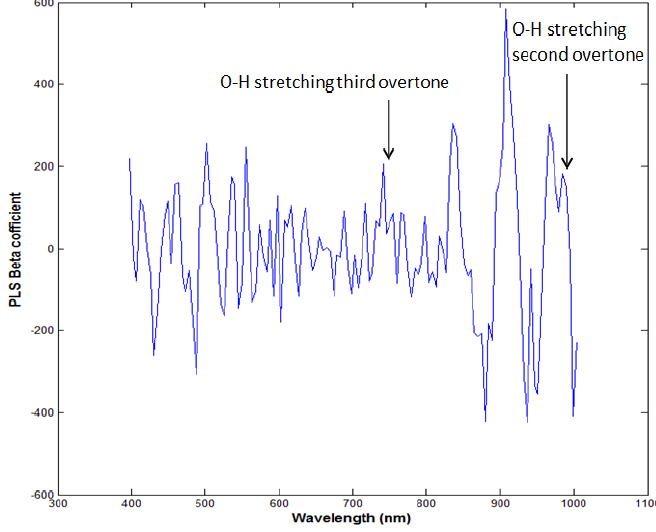
Figure 6. Beta coefficient plot of moisture content with PLSR model in the range of 400–1,000